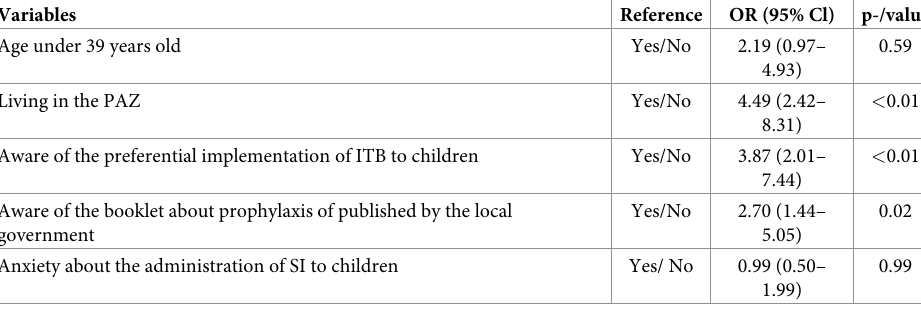
Table 3. Logistic regression analysis of guardians who received